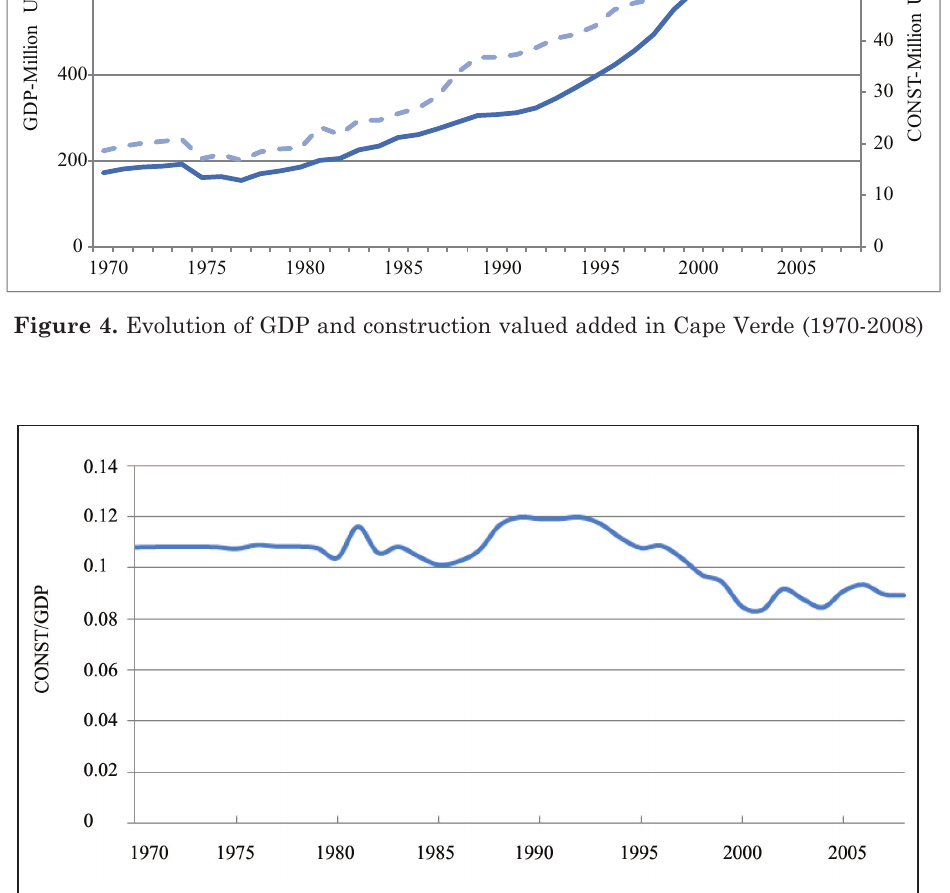
figure 5. Share of construction valued added in GDP in Cape Verde